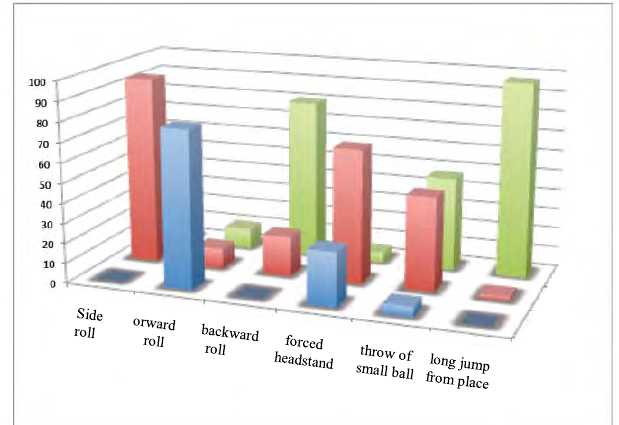
Fig.2. Diagram of relation of mean squares (%). 15 years’ age boys: line1— Х 1 (quantity of repetitions), line 2 — Х 2 (rest interval), line 3 — Х 1 Х 2 (interaction of quantity of repetitions and rest intervals)